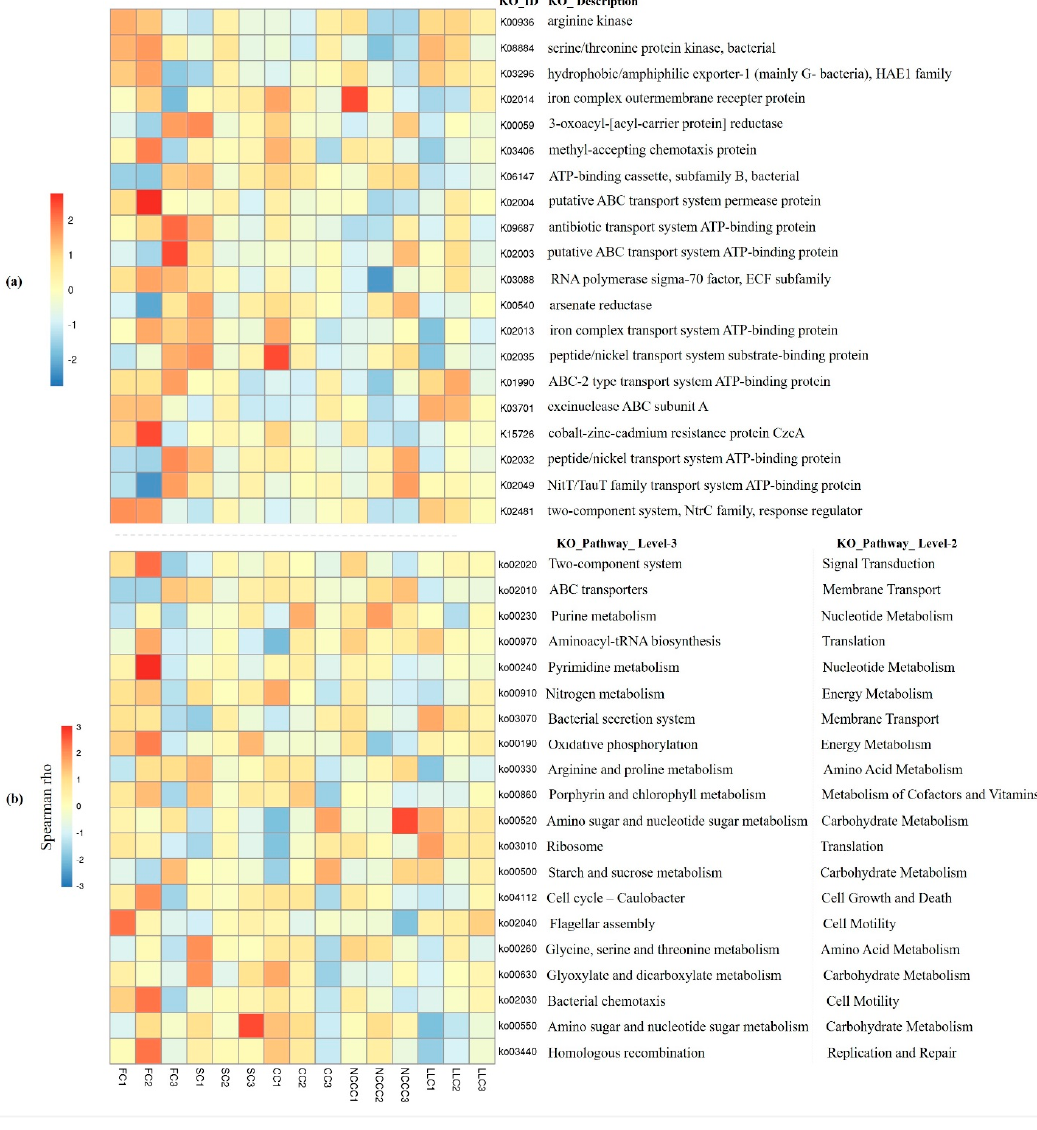
Figure 7. Heatmap based most abundant Kyoto Encyclopedia of Genes and Genomes (KEGG) ortholog (KO) groups in microbiome samples ( a ) Imputed metagenomes reveal the relative abundance of only top 20 KEGG metabolic pathways across all the soil samples ( b ). KEGG metabolic pathways correlating positively or negatively within abundant genes at p -value < 0.05.